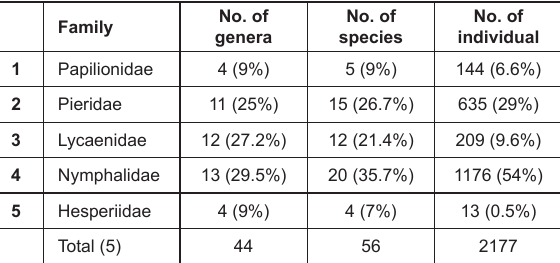
Table 1. Total number, percentage of genus, species and individuals collected per family